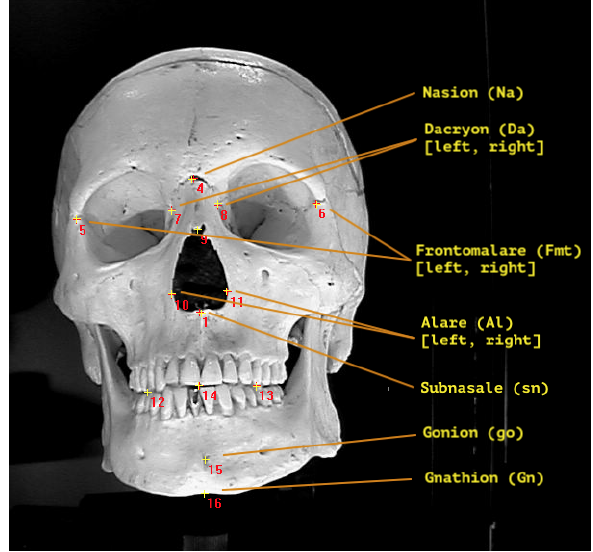
Figure 4. Landmarks used in